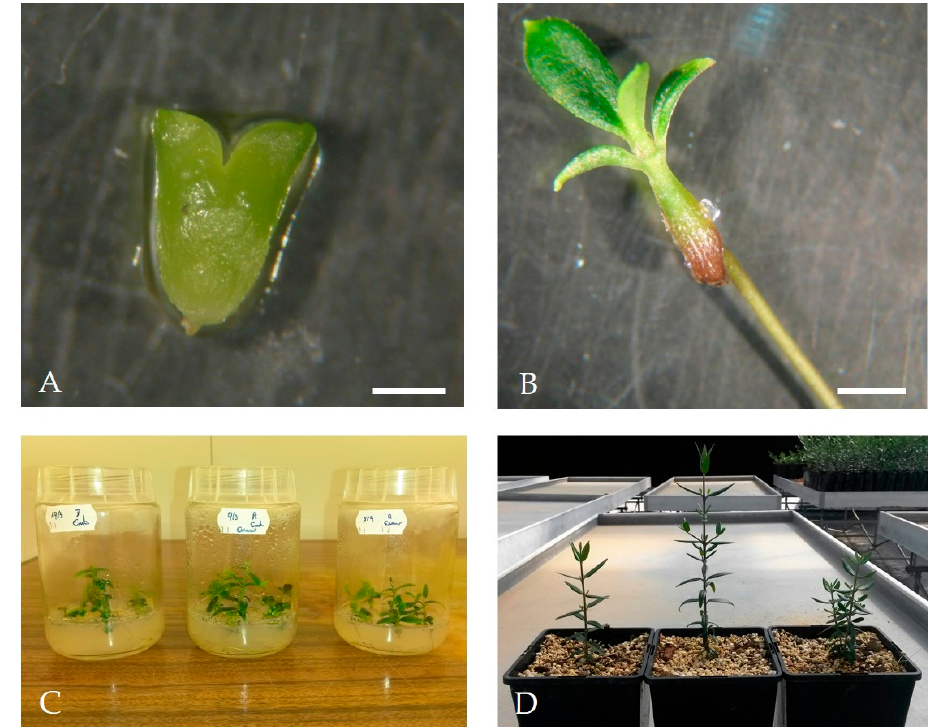
Figure 7. ( A ) Somatic embryo at the cotyledonary stage in light condition; ( B ) Plant from the somatic embryo in OMc without growth regulators; ( C ) Embryos convert into normal plants after 12 weeks and ( D ) Plants after acclimatization stage. Bars: 10 mm.